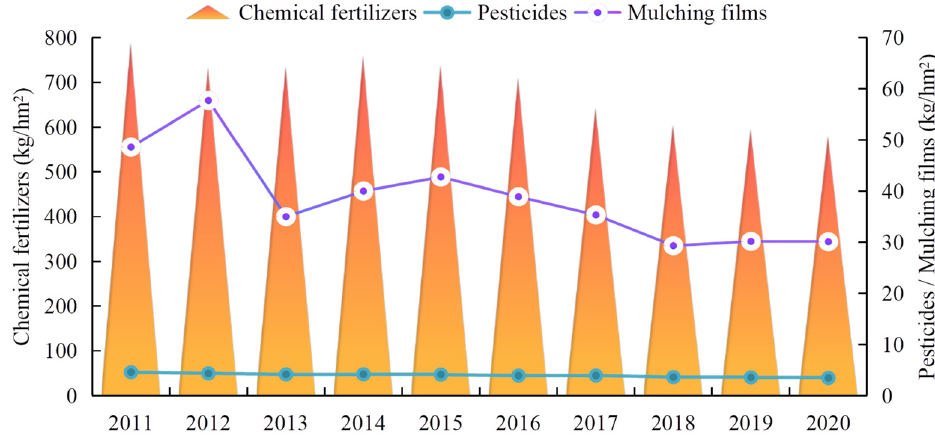
Figure 5. Consumption of chemical fertilizers, pesticides, and mulching films per unit area of cultivated land in Ganzhou district from 2011 to 2020.